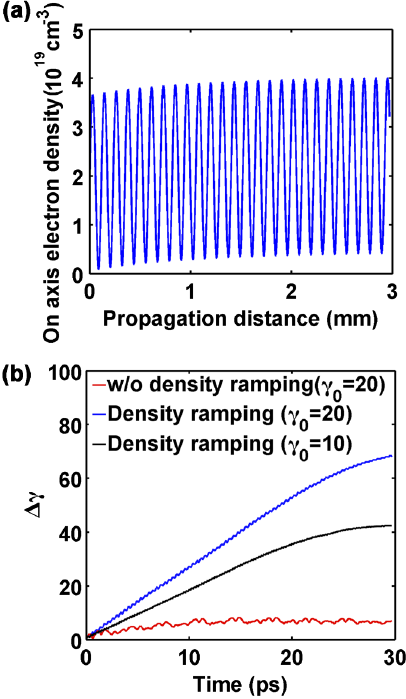
FIG. 10. (a) On-axis electron density for a plasma waveguide with a density ramp. The ramp allows trapping of lower energy electrons in this case (cid:1) 0 ¼ 20 for a normalized vector potential of a 0 ¼ 0 : 1 . (b) Energy gain of (cid:1) 0 ¼ 20 electrons with (blue) and without (red) the density ramp pictured in (a). The energy gain of (cid:1) 0 ¼ 10 electrons is the black line in